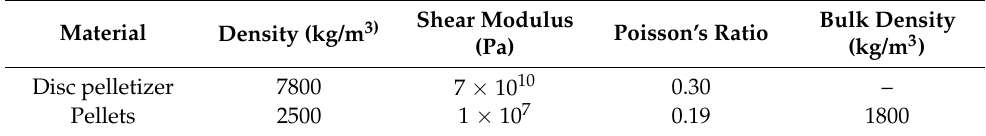
Table 2. Contact parameters.